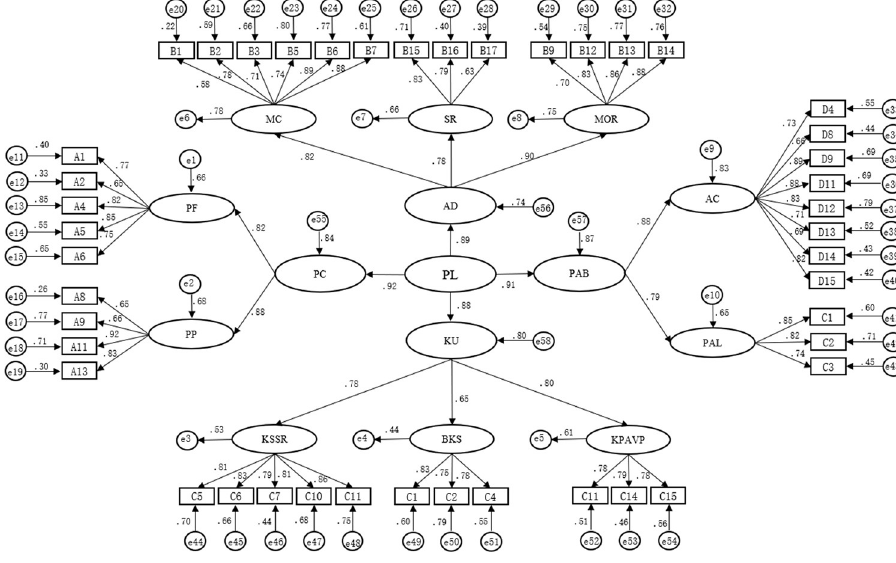
Fig 4. The second-order of factor structure and standardized factor loading on self- assessment physical literacy items.